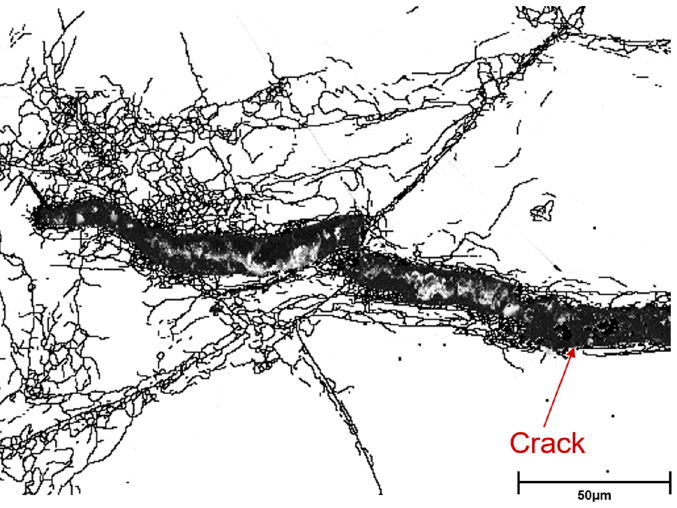
Figure 8. Sub-grain formation in ferritic Crofer ® 22 H, observed in the specimen, failed after 4342 TMF-cycles [5].